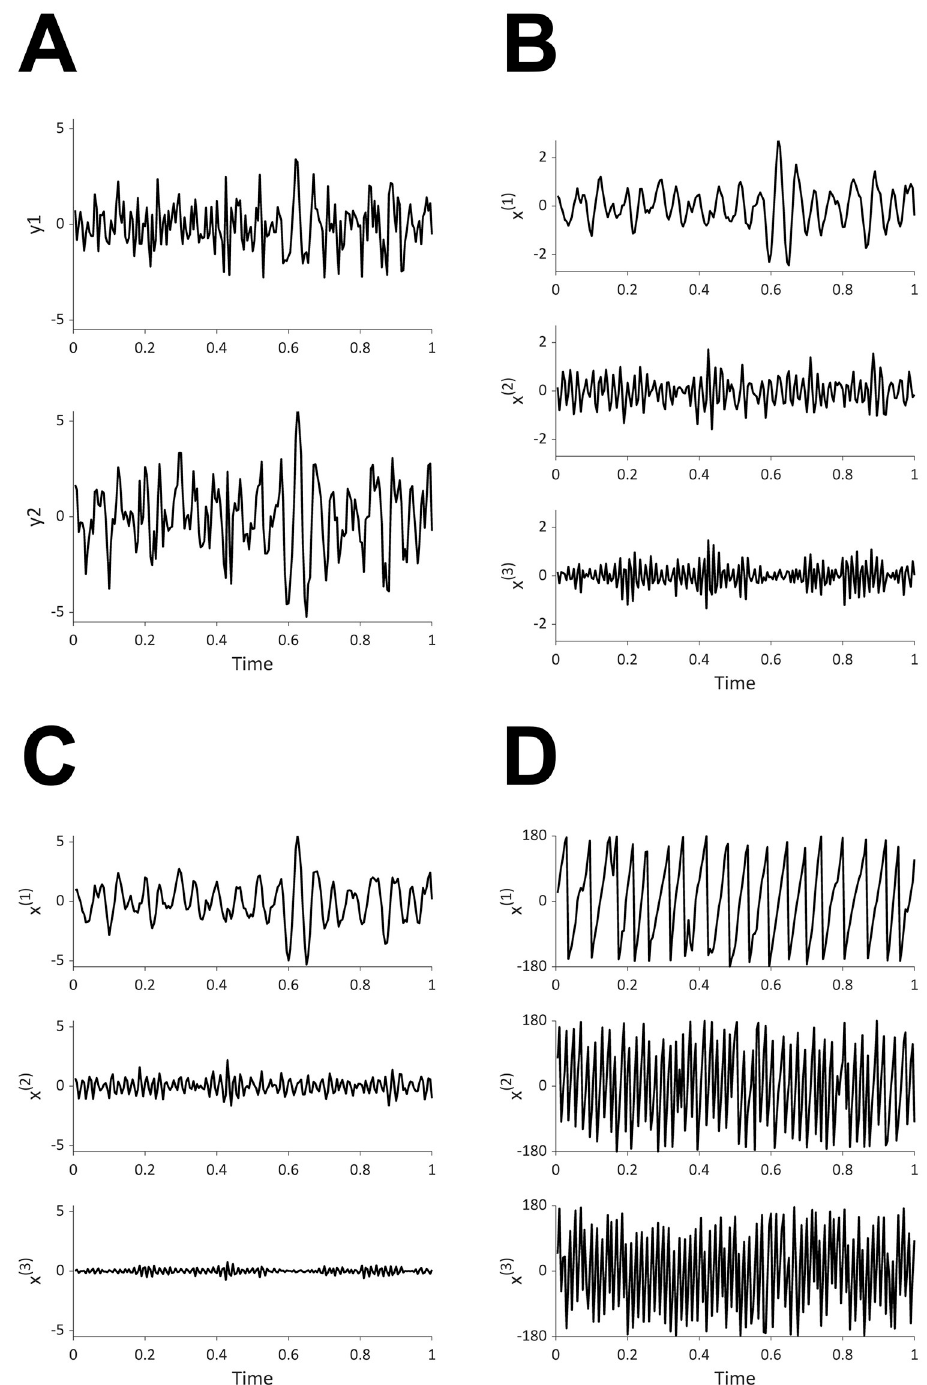
Fig 2. OSC-DECOMP for bivariate time series data. (A) Input data. (B) Decomposition into three oscillation components of the first time series. (C) Decomposition into three oscillation components of the second time series. Although the waveform may look almost the same, the scale is different from (B). (D) Phase of extracted oscilators (in degrees).